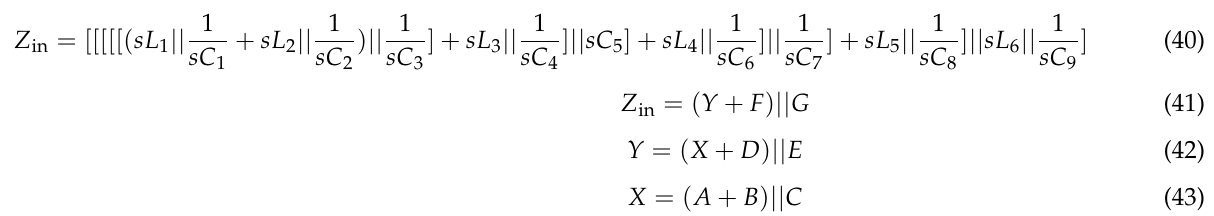
Figure 9. First-order